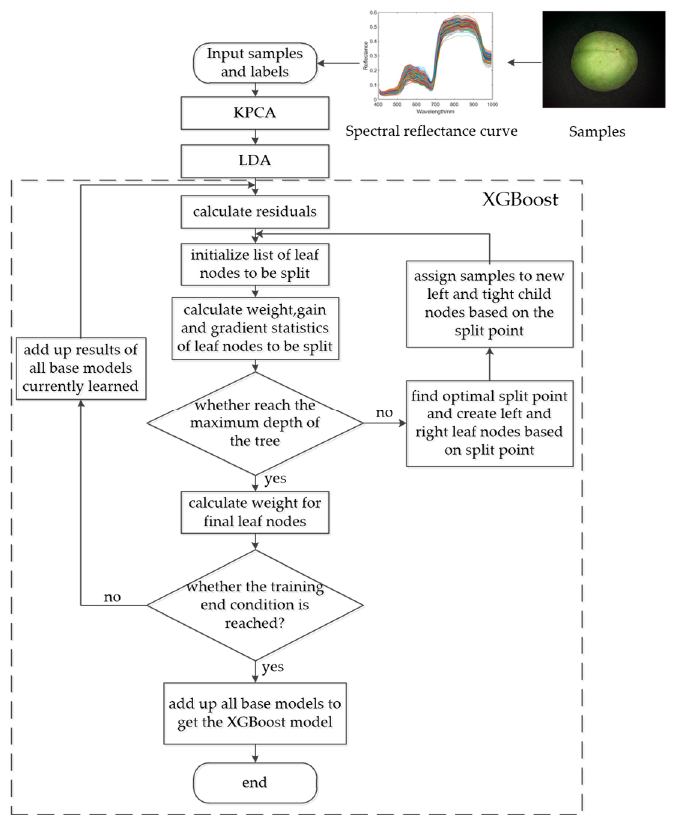
Figure 5. Flow chart of the kernel principle component analysis- linear discriminant analysis- extreme gradient boosting algorithm (KPCA-LDA-XGB) model training.